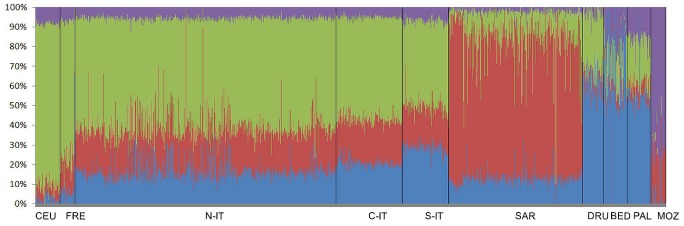
Identity-by-state (IBS) sharing between and within populations.Density estimates for empirical distributions of genome-wide mean proportions of alleles sharing identity-by-state between subjects from different population or within the same populations, are shown for A) Northern Europe (CEU and French), B) Middle East (Bedouin, Palestinian and Druze), C) Northern Africa (Mozambite), D) within Italian populations. Color code as in Figures 1 and 2.